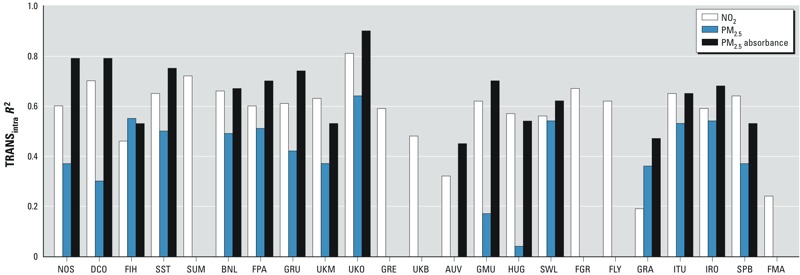
Transferability (TRANSintra
R2) of the European models for NO2 and PM in the 23 study areas. See Table 1 for study area codes.